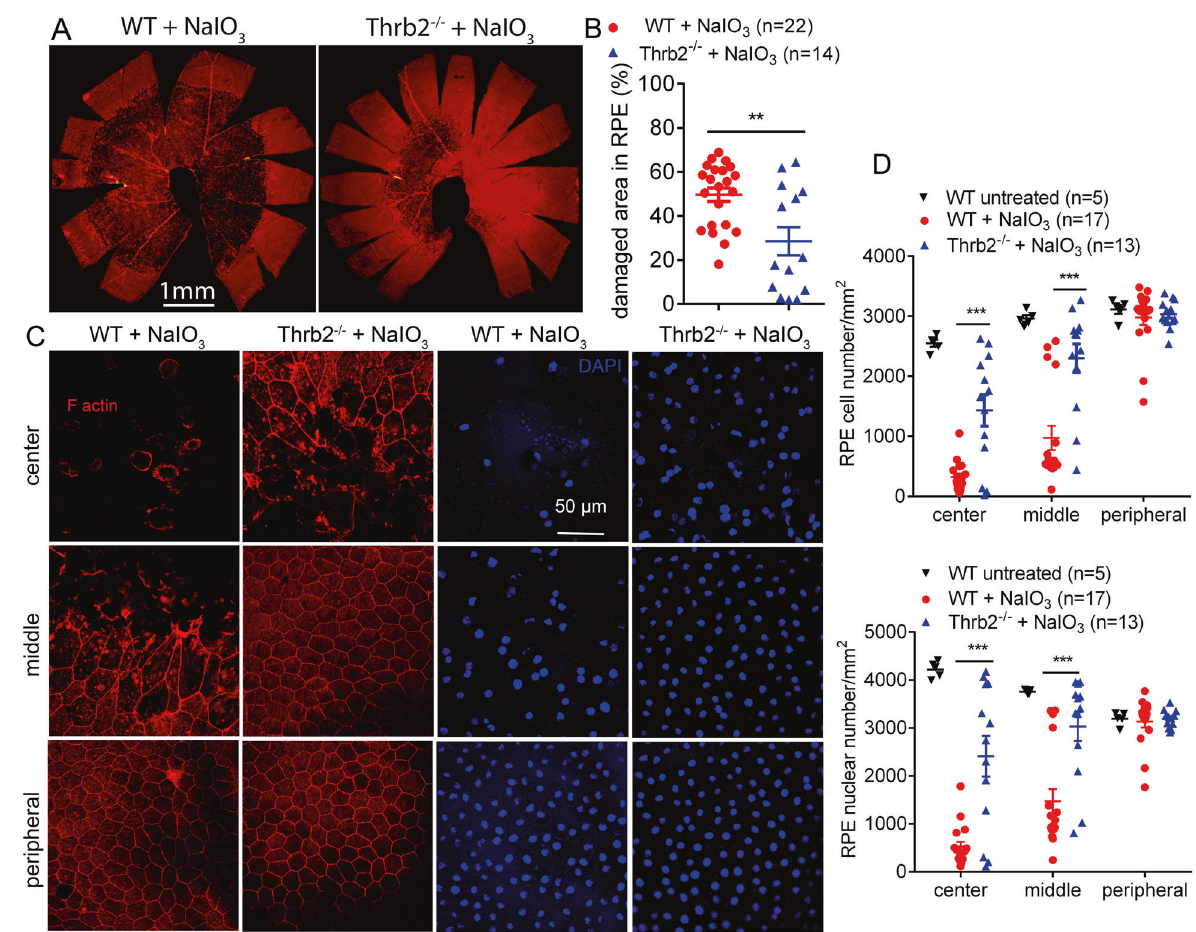
NaIO 3 injection. A , B Shown are representative low-magni fi cation images of phalloidin staining of the damaged area in the RPE ( A ) and corresponding quantitative analysis of the damaged area ( B ). C , D Shown are representative high-magni fi cation images of phalloidin staining and DAPI labeling taken at different regions of the RPE ( C ) and corresponding quantitative analysis of RPE cell numbers and RPE nuclear numbers ( D ). Data are represented as means ± SEM for 5 – 22 mice per group (** p < 0.01, *** p < 0.001, compared with wild-type mice treated with NaIO 3